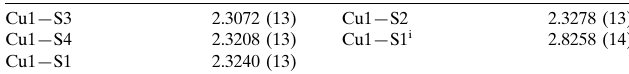
Selected bond lengths (A˚